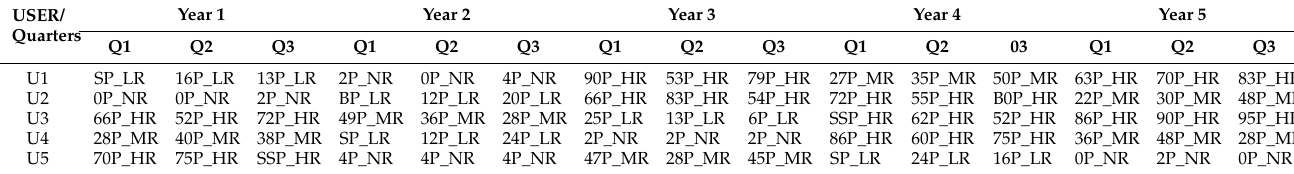
Table 6. Driver risk score over 5 years processing by CF user/user similarity matrix.